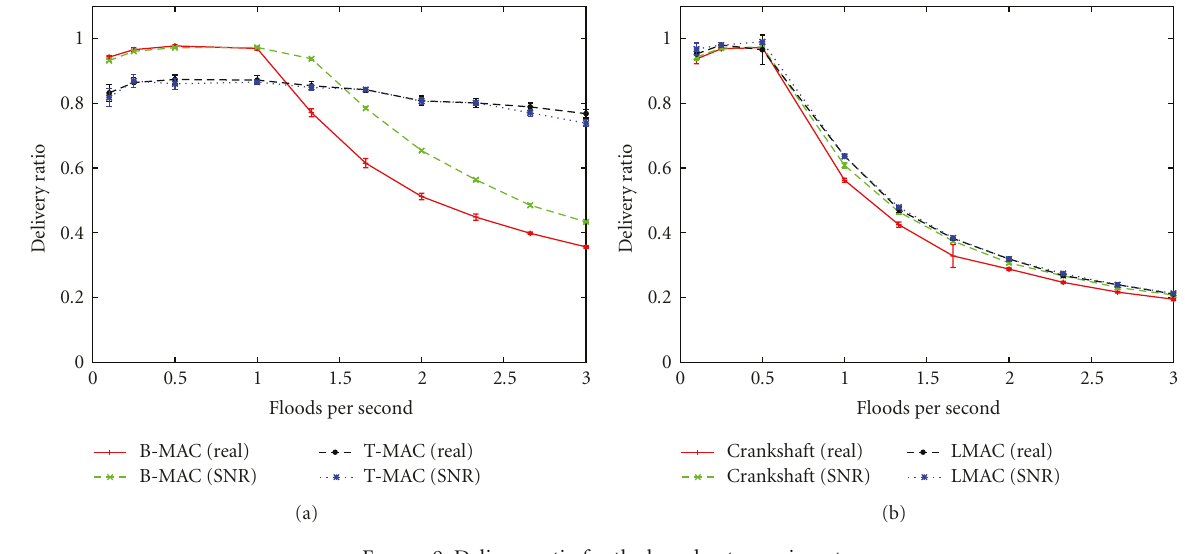
Figure 9: Delivery ratio for the broadcast